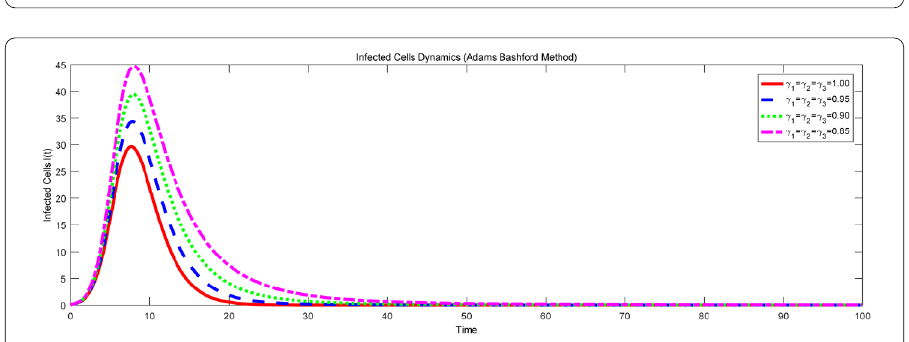
Figure 2 Dynamics of S ( t ) with γ i = 1 (solid red line), γ i = 0.95 (dashed blue line), γ i = 0.9 (dotted green line) and γ i = 0.85 (dotted dashed magenta line), i = 1,2,3.